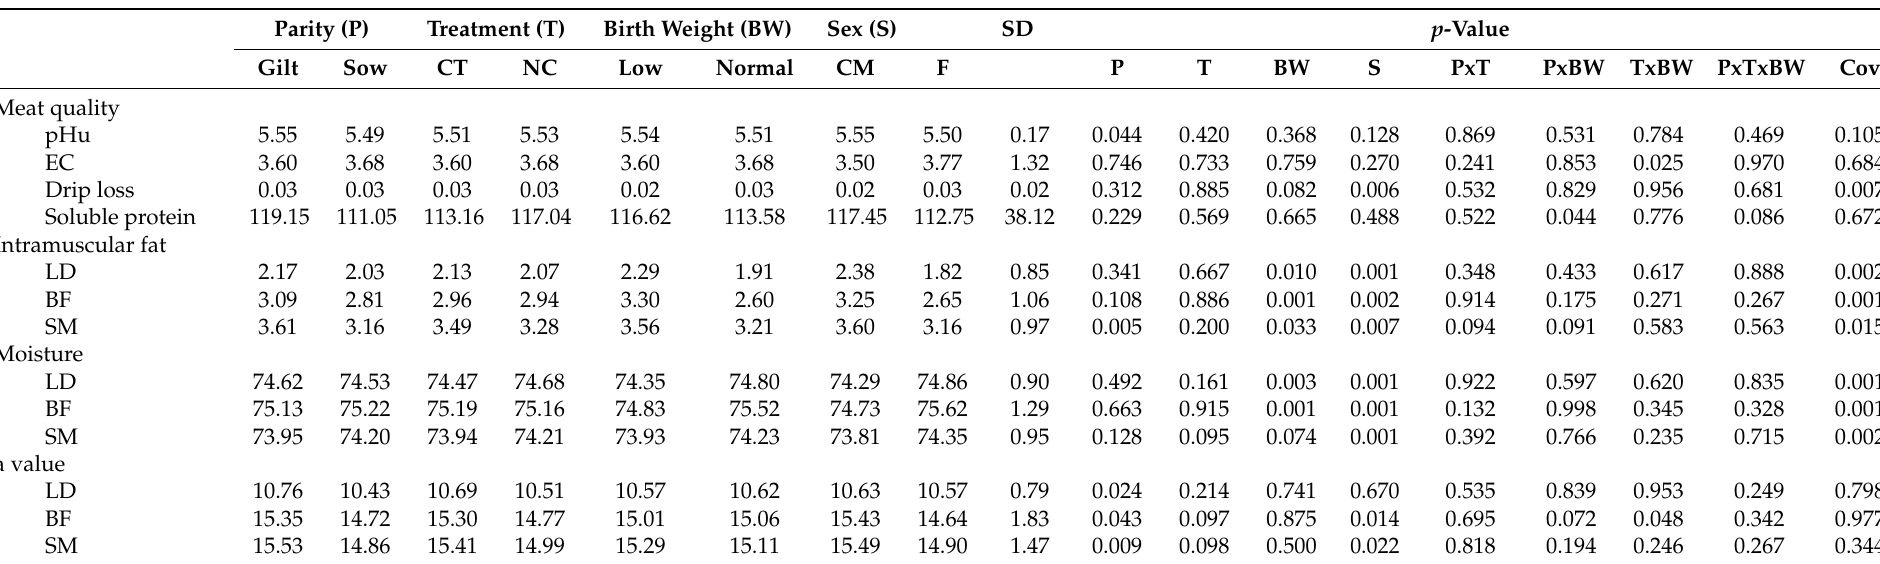
Table 4. Effect of parity (P), neonatal care treatment (T), birth weight (BW), and sex (S) on selected meat quality characteristics (covariable carcass